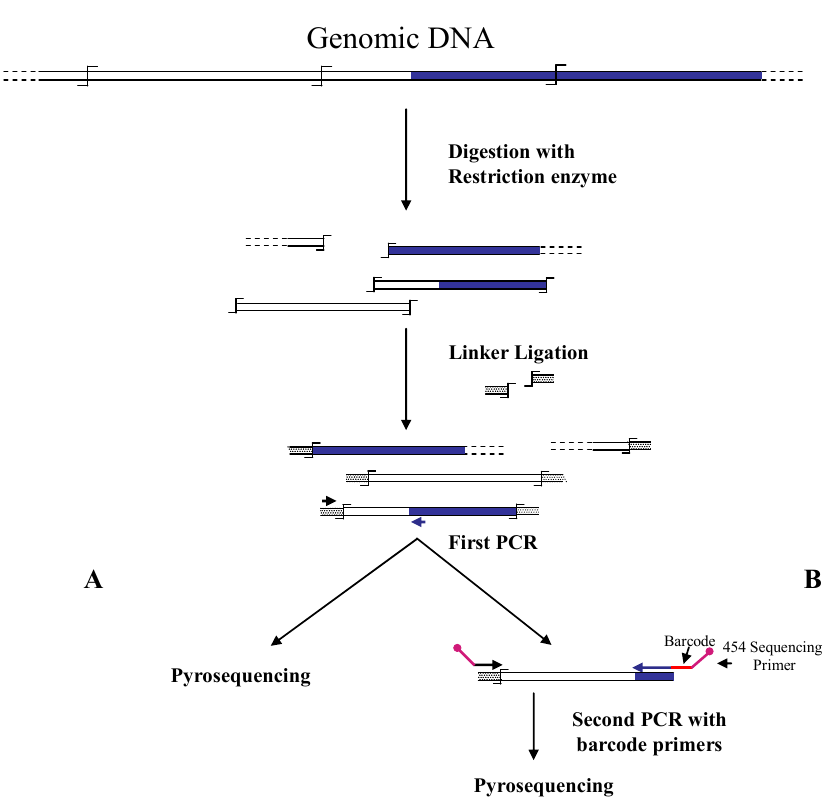
Figure 1. Main steps of cassette-PCR genome walking (GW) and pyrosequencing association strategies. The original strategy reported by Wang et al. [6] ( A ) and its improvement by the adoption of barcoded primers [13] ( B ) are illustrated. Blue and white bars correspond to known and unknown sequences, respectively. A black horizontal arrow indicates adapter specific primers; a blue arrow represents primers designed in the known region. The symbol indicates a restriction site. Barcodes and 454 sequencing traits of longer amplification primers are indicated in the